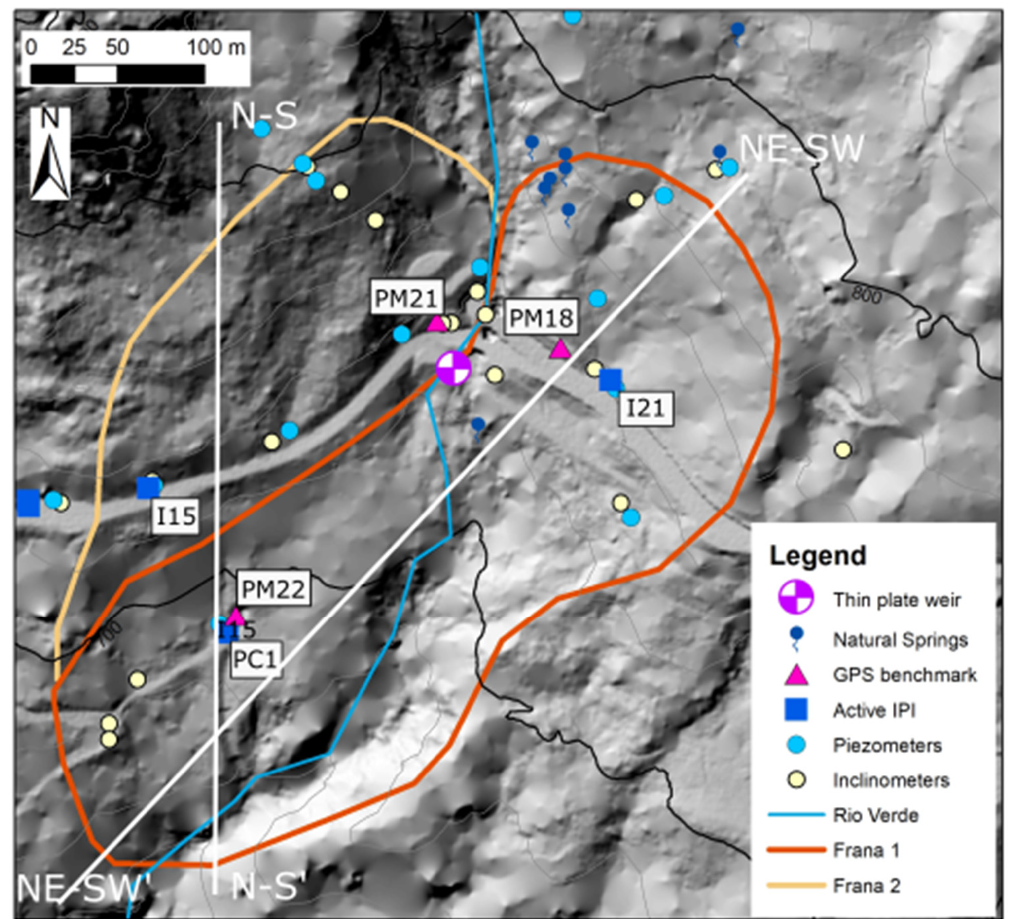
Figure 3. The monitoring network deployed in Frana 1-2.